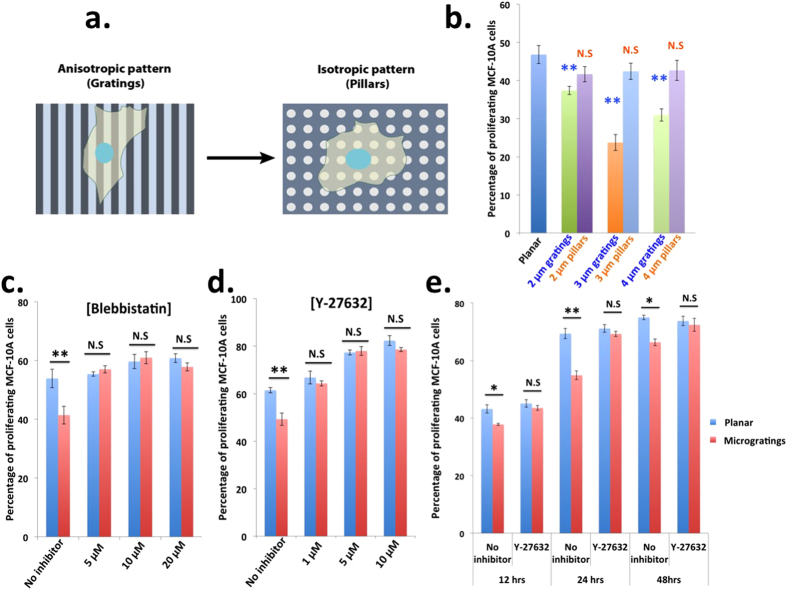
Microgratings reduces MCF-10A proliferation through the activation of Rho-ROCK-Myosin pathway.(a) Schematic representation of the morphology of cells seeded on anisotropic (gratings) and isotropic (pillars) patterns. (b) MCF-10A proliferation decreased on microgratings but not on micropillars of different diameters. Acto-myosin contractility plays a crucial role in the reduction of proliferation of MCF-10A cells on microgratings. Acto-Myosin contraction inhibitory drug treatment: (c) Blebbistatin (5 μM, 10 μM, 20 μM), (d) Y-27632 (1 μM, 5 μM, 10 μM), (e) Time course of cell proliferation after treatment with acto-myosin contraction inhibitory drug Y-27632 (5 μM) for various time points. Blue bar indicates planar and red indicates 2 μm microgratings. Data are means ± s.e.m. (n = 3). For each experiment, 300 cells were considered on an average. P values were obtained using Student’s unpaired t-test. **p < 0.01 with respect to planar. N.S. denotes non-significant difference compared to planar.